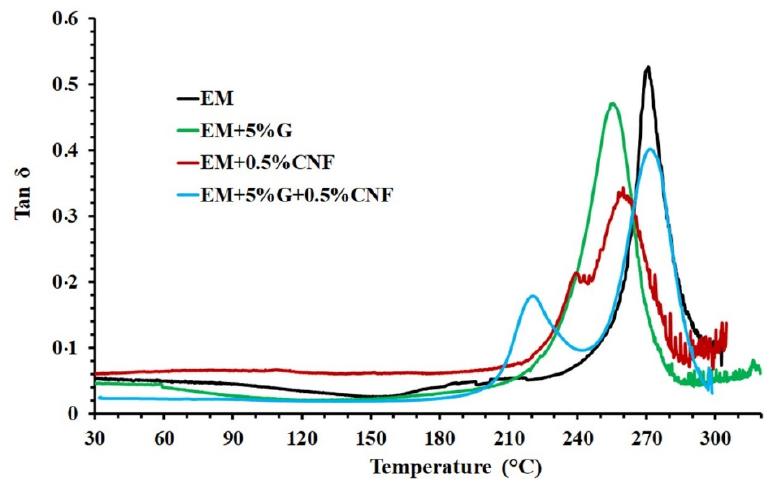
Figure 6 . Loss factor (tan δ ) of the epoxy samples isothermally solidified. Figure 6. Loss factor (tan δ ) of the epoxy samples isothermally